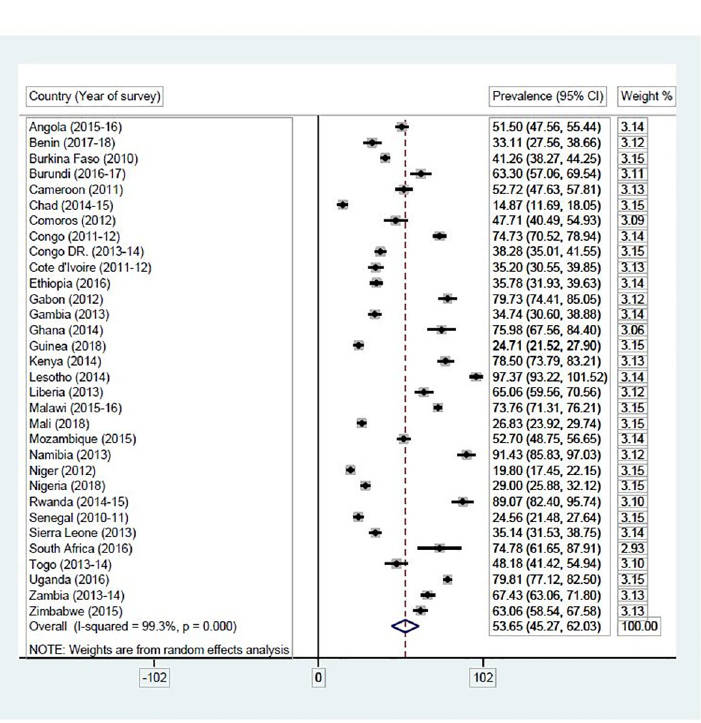
Fig 3. Proportion of female adolescents in SSA who can ask their partners to use condom during sex. Source: Authors’ computations.